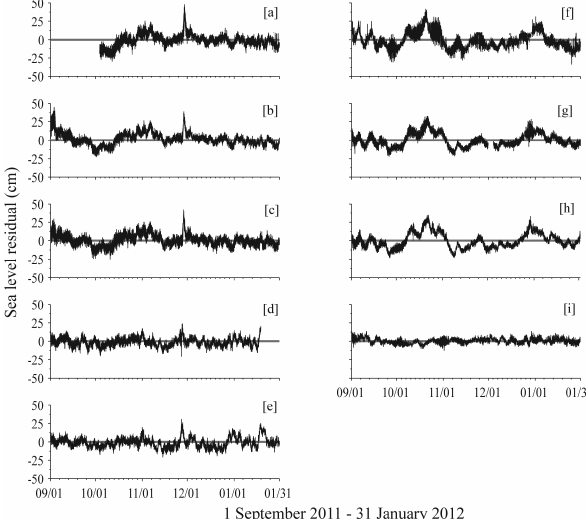
Figure 2. Cyclone parameters during E1 (a) wind speed, (b) sea level pressure, and (c) storm forward translation speed. Similarly, cyclone parameters during E2 (d) wind speed, (e) sea level pres- sure, and (f) storm forward translation speed. Note: IMD-India Me- teorological Department; JTWC-Joint Typhoon Warning Center; UNISYS-Unisys Weather (http://weather.unisys.com/hurricane/).